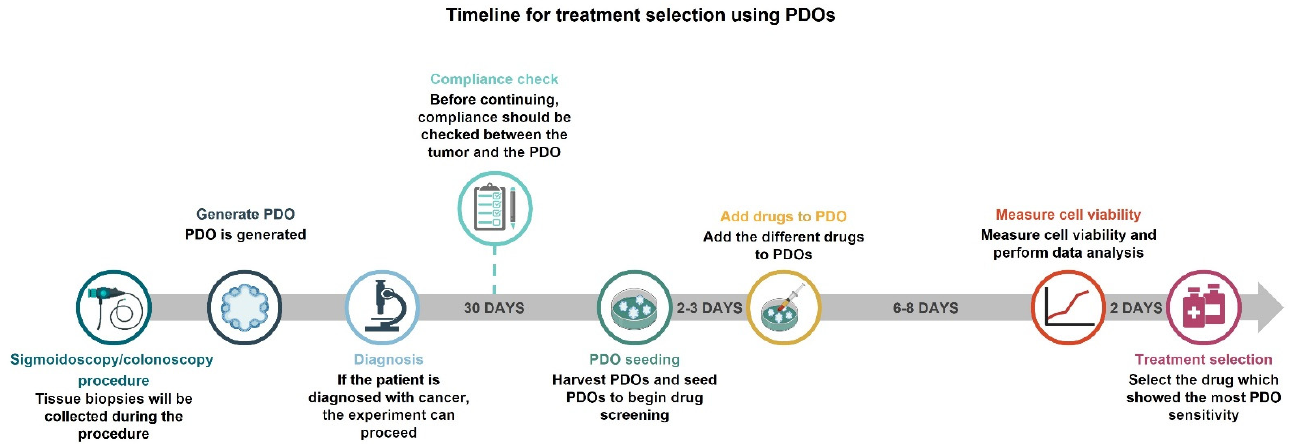
Figure 3. Estimated timeline for treatment selection using PDOs. Biopsies will be obtained at endoscopic procedures and a diagnosis will be made. Subsequently, PDOs will be generated from the biopsies. It is necessary to ensure compliance between PDOs and corresponding tissue before proceeding. After 30 days of culture, the harvested PDOs will be seeded for drug screening. After recovering for 2–3 days, they will be exposed to the library of drugs. Six days later, the cell viability will be measured, and data will be analyzed to select the appropriate treatment. PDOs, patient- derived organoids.